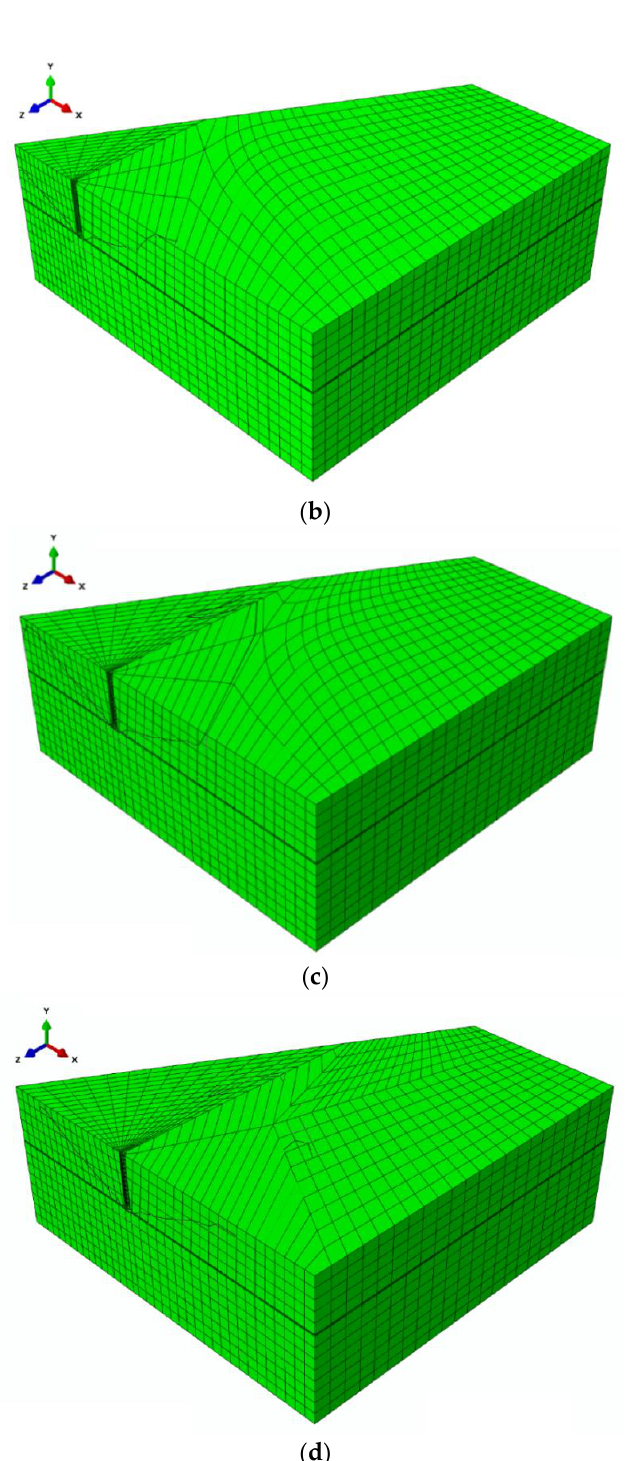
Figure 9. Rock break-out for the 3-anchor system of fasteners, r i : ( a ) 115.47 mm, ( b ) 230.94 mm, ( c ) 346.41 mm, ( d ) 404.14 mm.